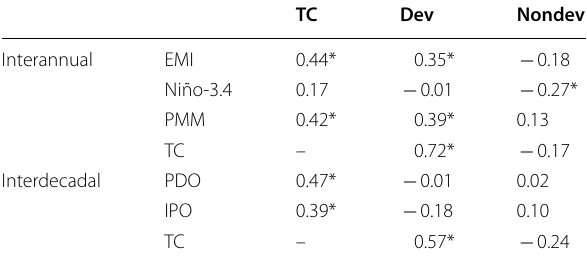
The asterisks indicate that the statistically significant at the 90% level